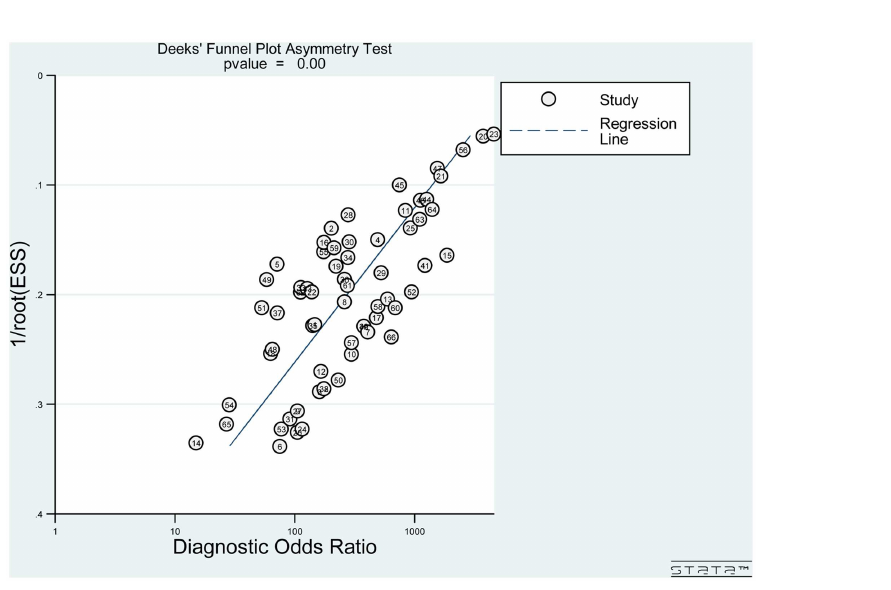
Fig 6. Deeks’ funnel plot with regression